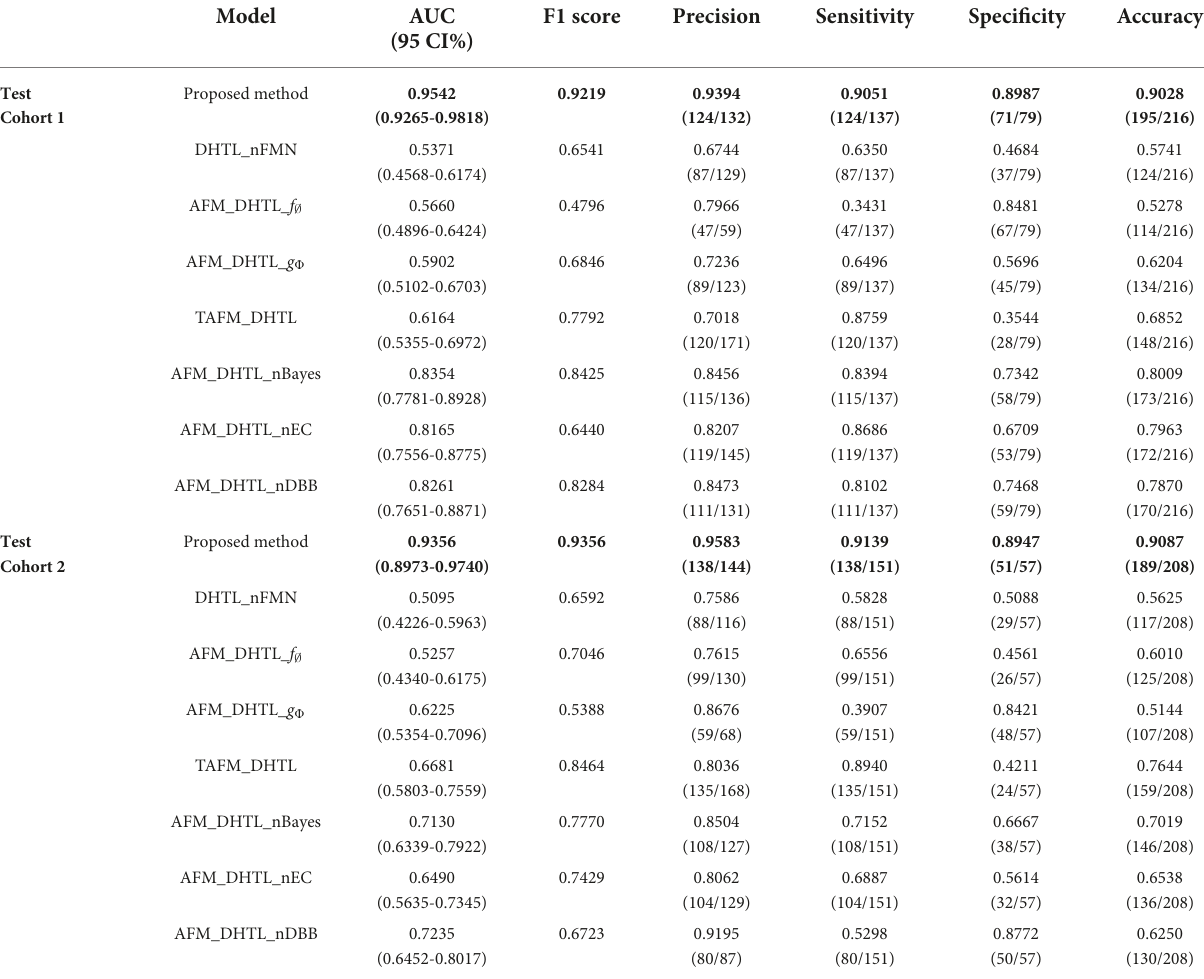
FIGURE10 The ROC curves of the proposed method and ablation experiments. (A) ROC of test cohort 1; ( B ) ROC of test cohort 2.